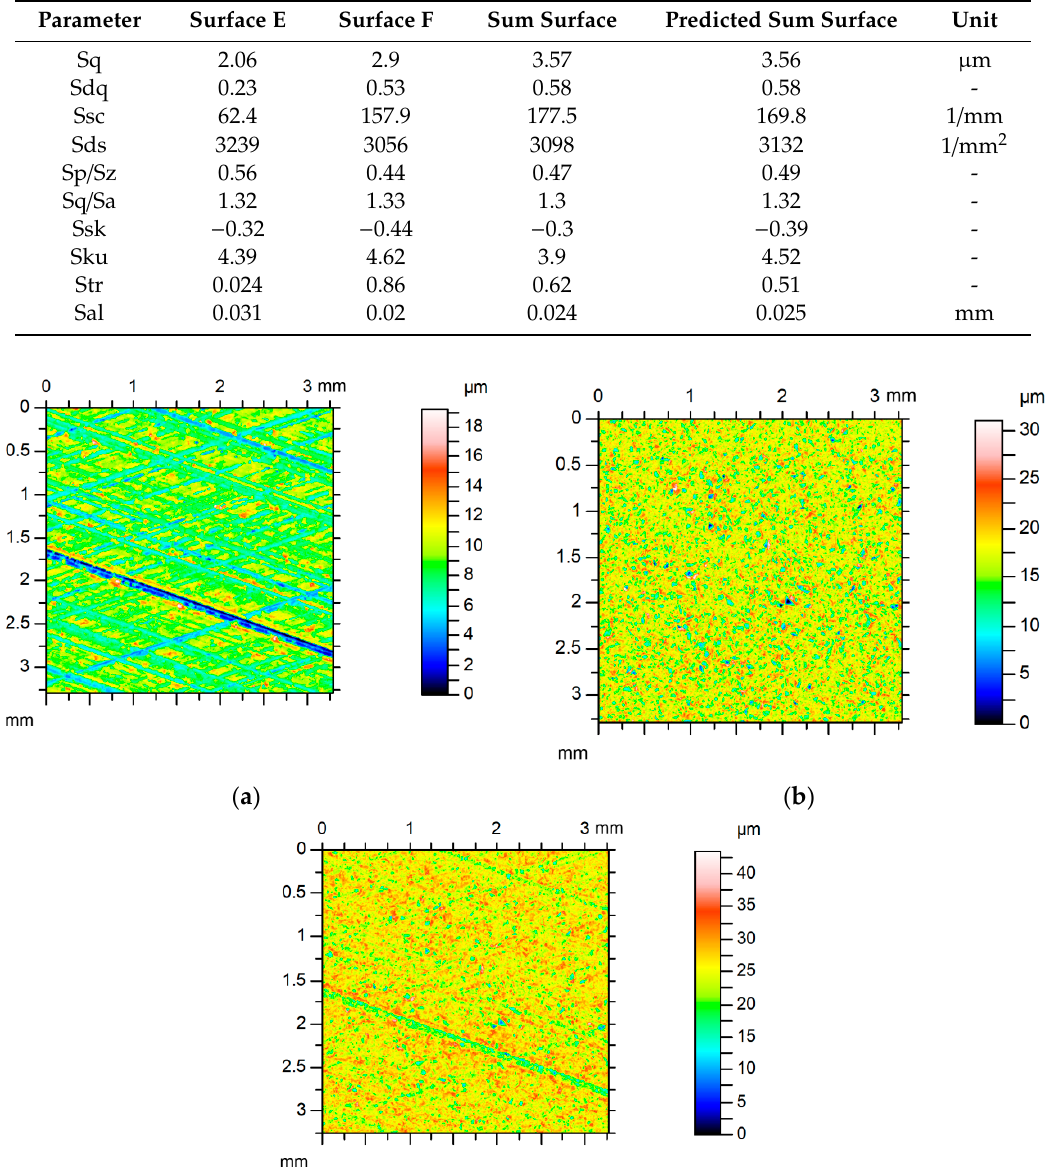
Table 5. Selected parameters of surface E, of surface F, of the sum surface, and of predicted parameters of the sum surface.